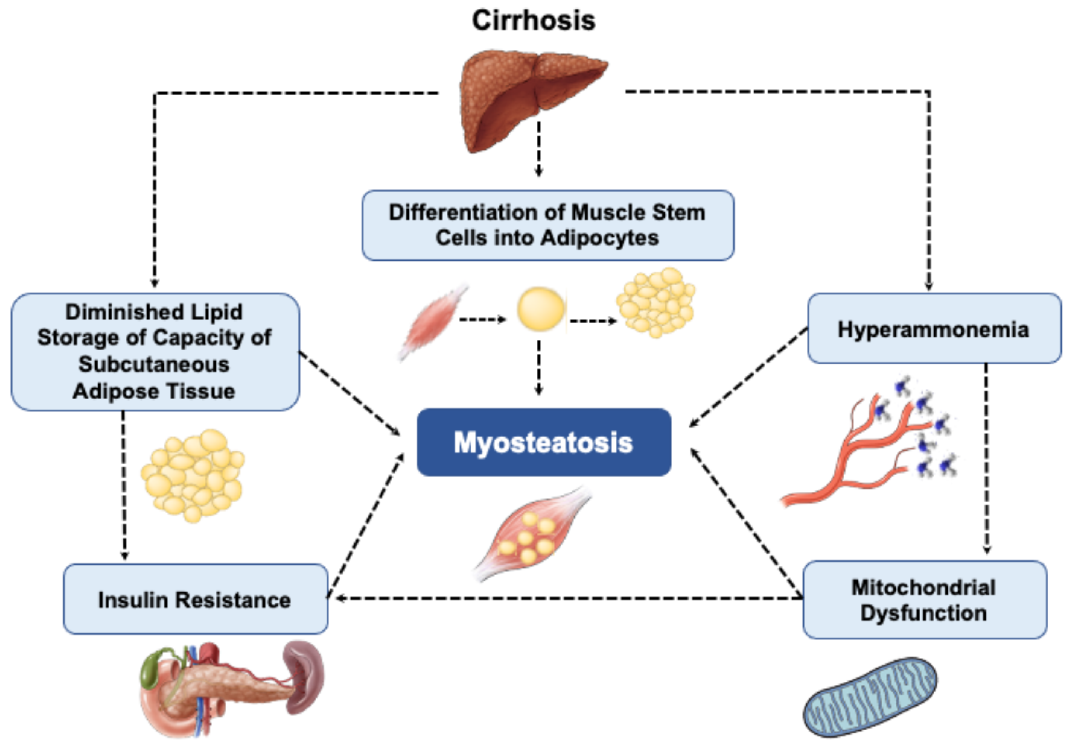
Figure 3. Summary of pathways contributing to myosteatosis in